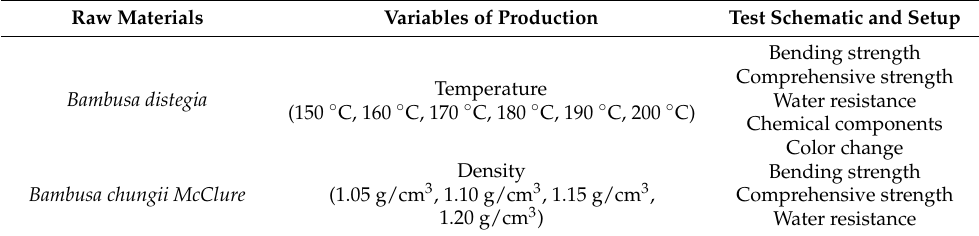
Table 1. Details on